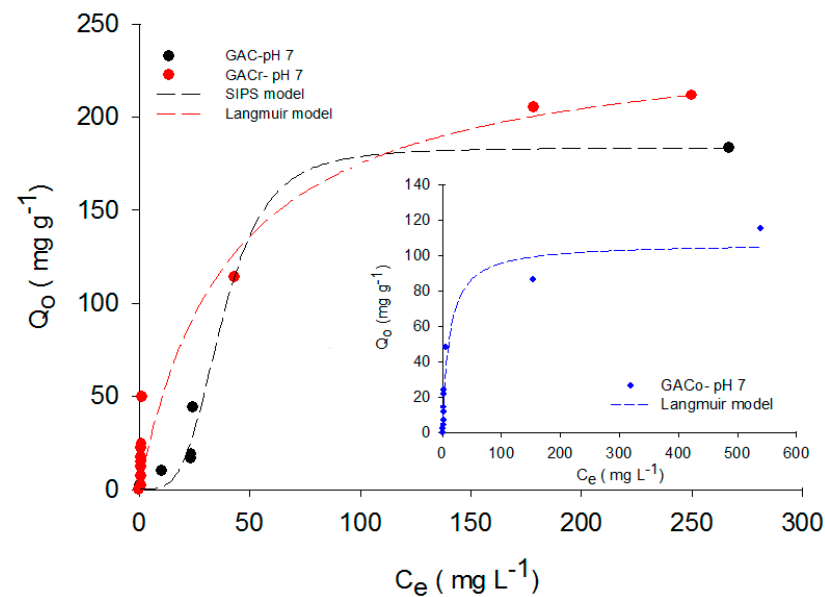
Figure 1. Paracetamol adsorption isotherms on GAC, GACo and GACr at pH 7 and T = 298 K.